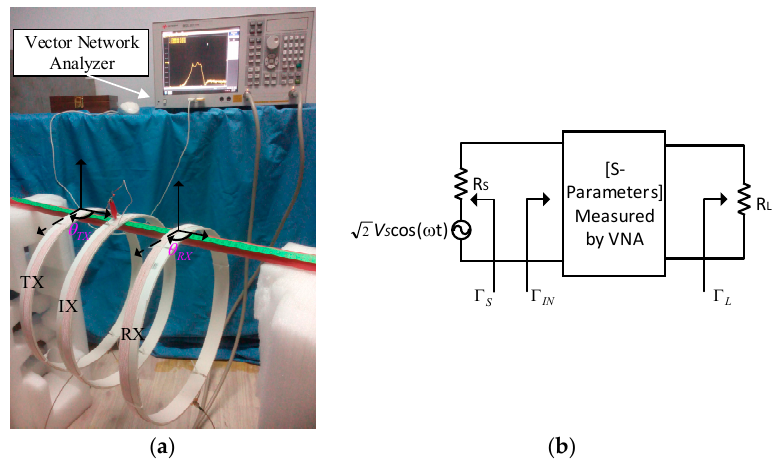
Figure 9. Experimental setup: ( a ) Measurement platform; and ( b ) Block diagram of a two ‐ port network is terminated by arbitrary R S and R L for calculating the PTE and PDL of the measuring system.